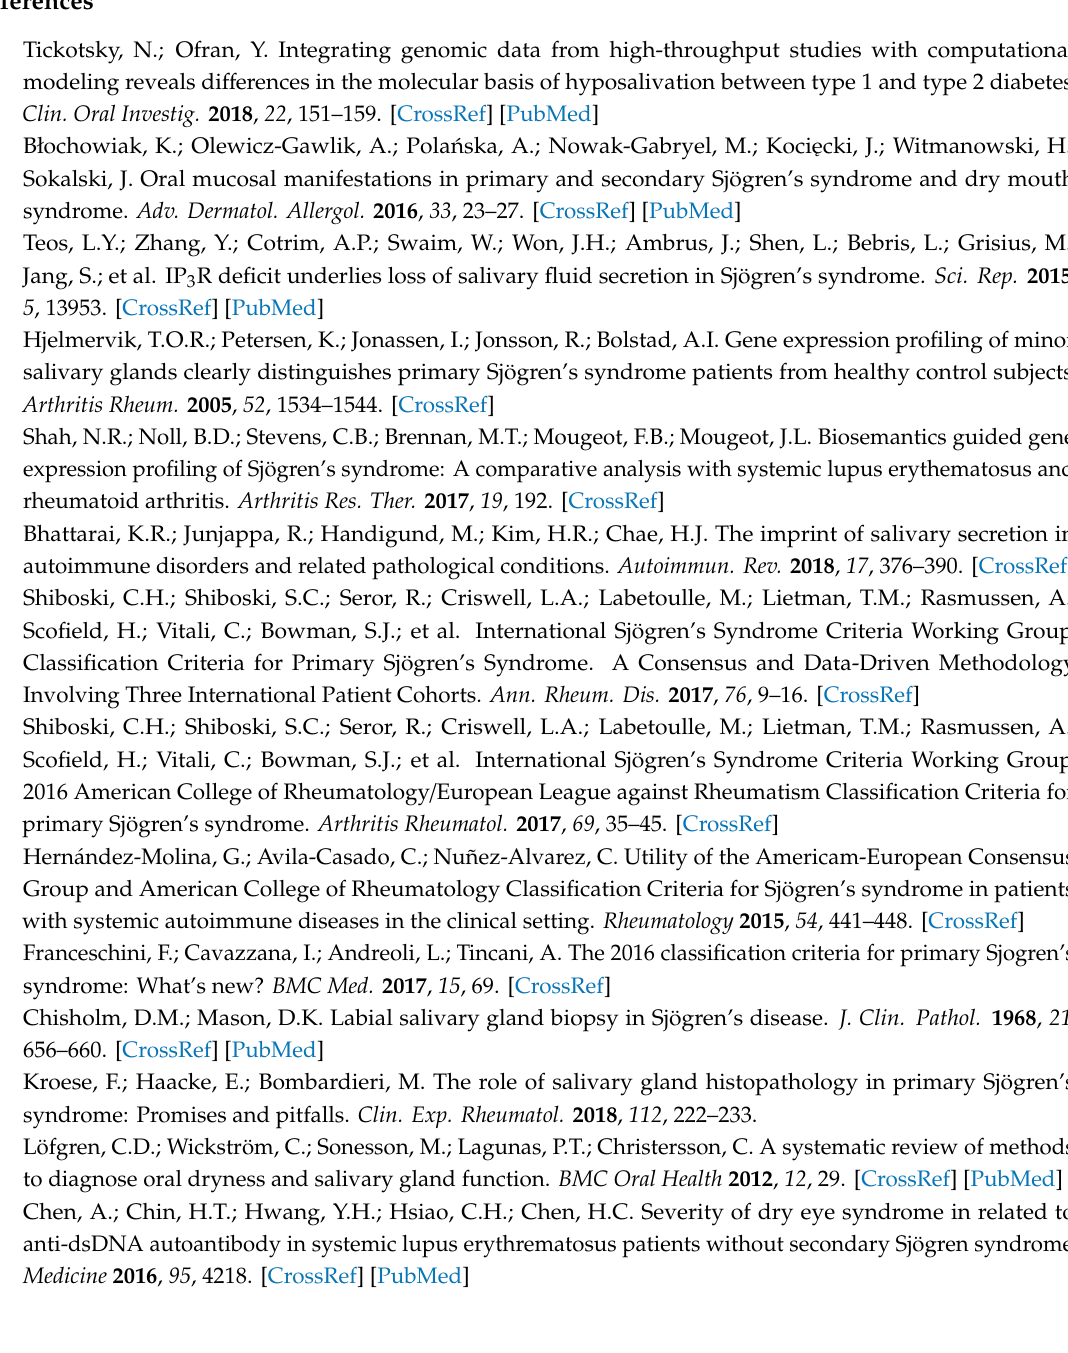
Table S1: Fold changes, adjusted p values of di ff erentially expressed genes belonging to the “secretion” GO BP term in SS (sicca) and SS (non-sicca)